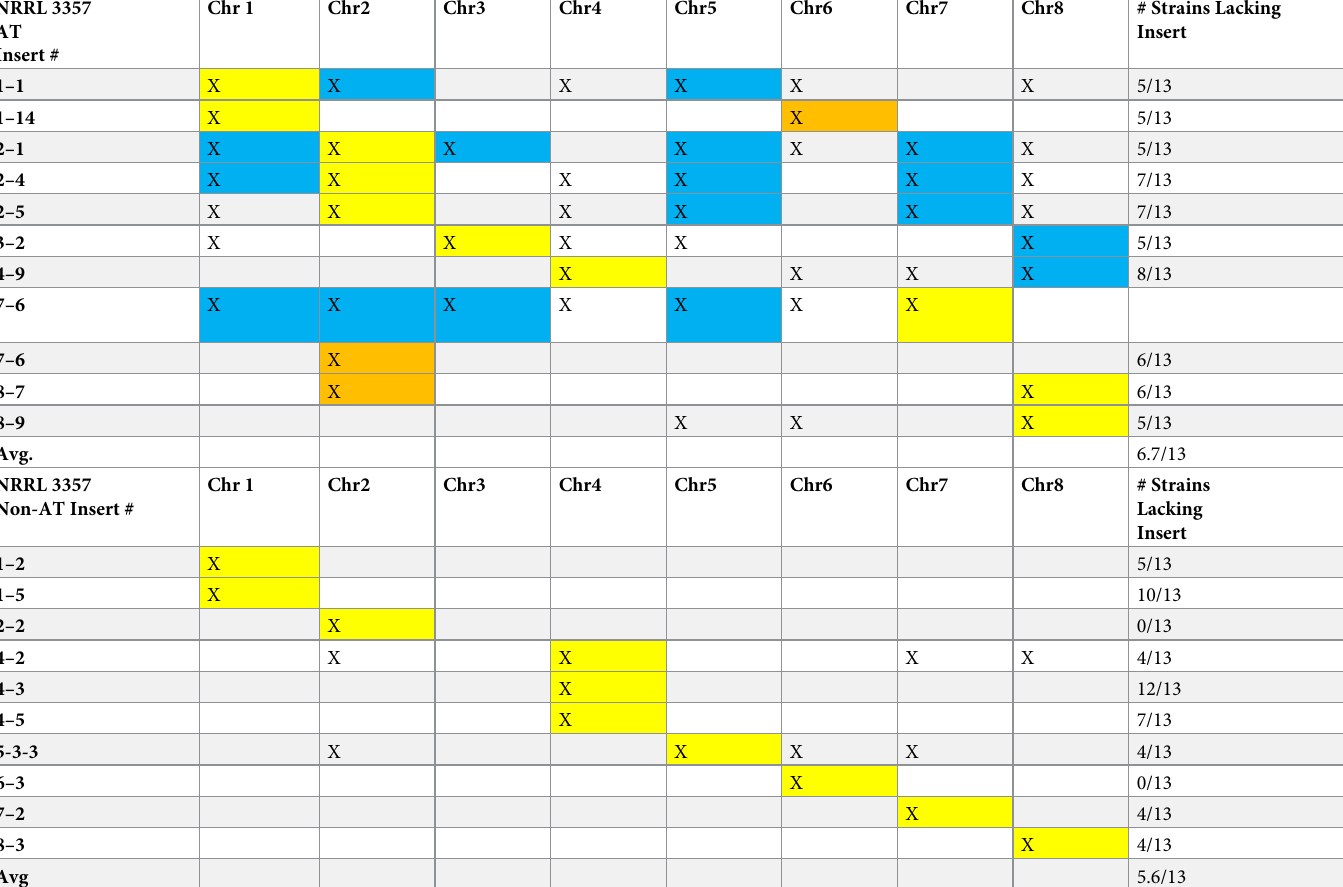
Table 1. Phylogenetic comparisons between NRRL 3357 and CA14 insertions reveal dispersion of AT insertions, and conservation of non-AT insertions. NRRL 3357 AT Insert #